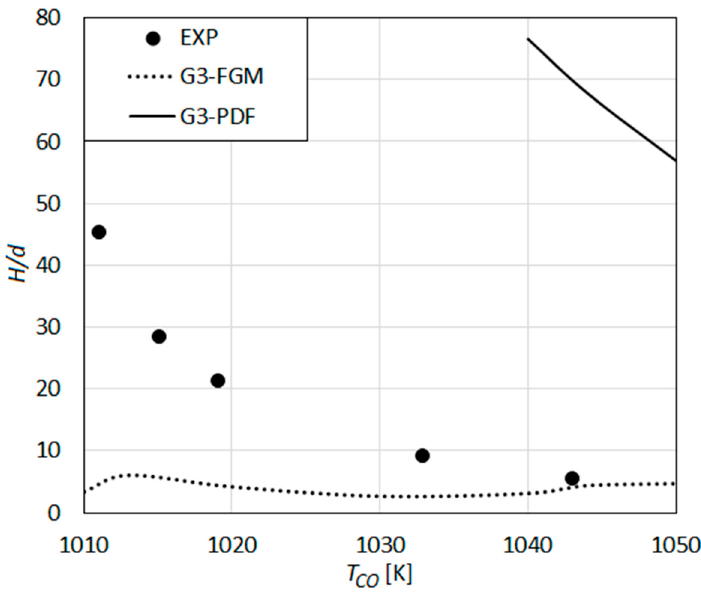
Figure 9. Lift-off height as a function of co-flow temperature: Predictions using the detailed reaction mechanism GRI-Mech 3.0 [59] compared with the measurements of Wu et al. [23].